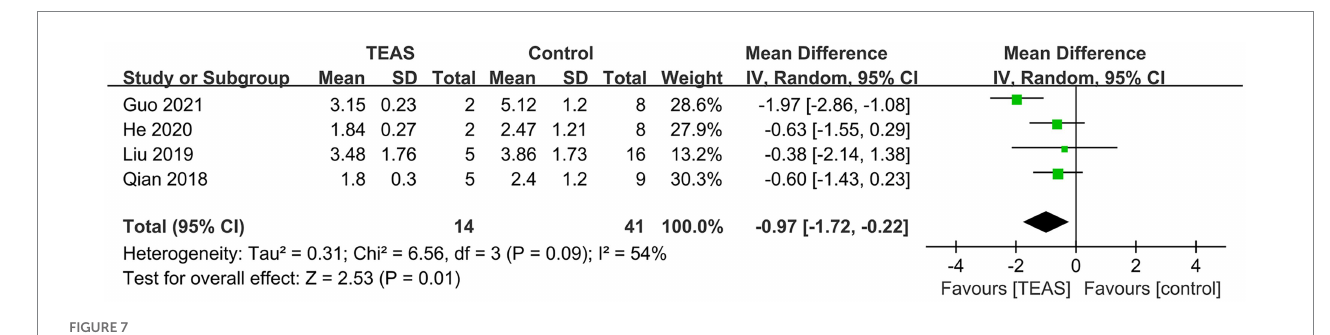
FIGURE 7 Forest plot of the duration of